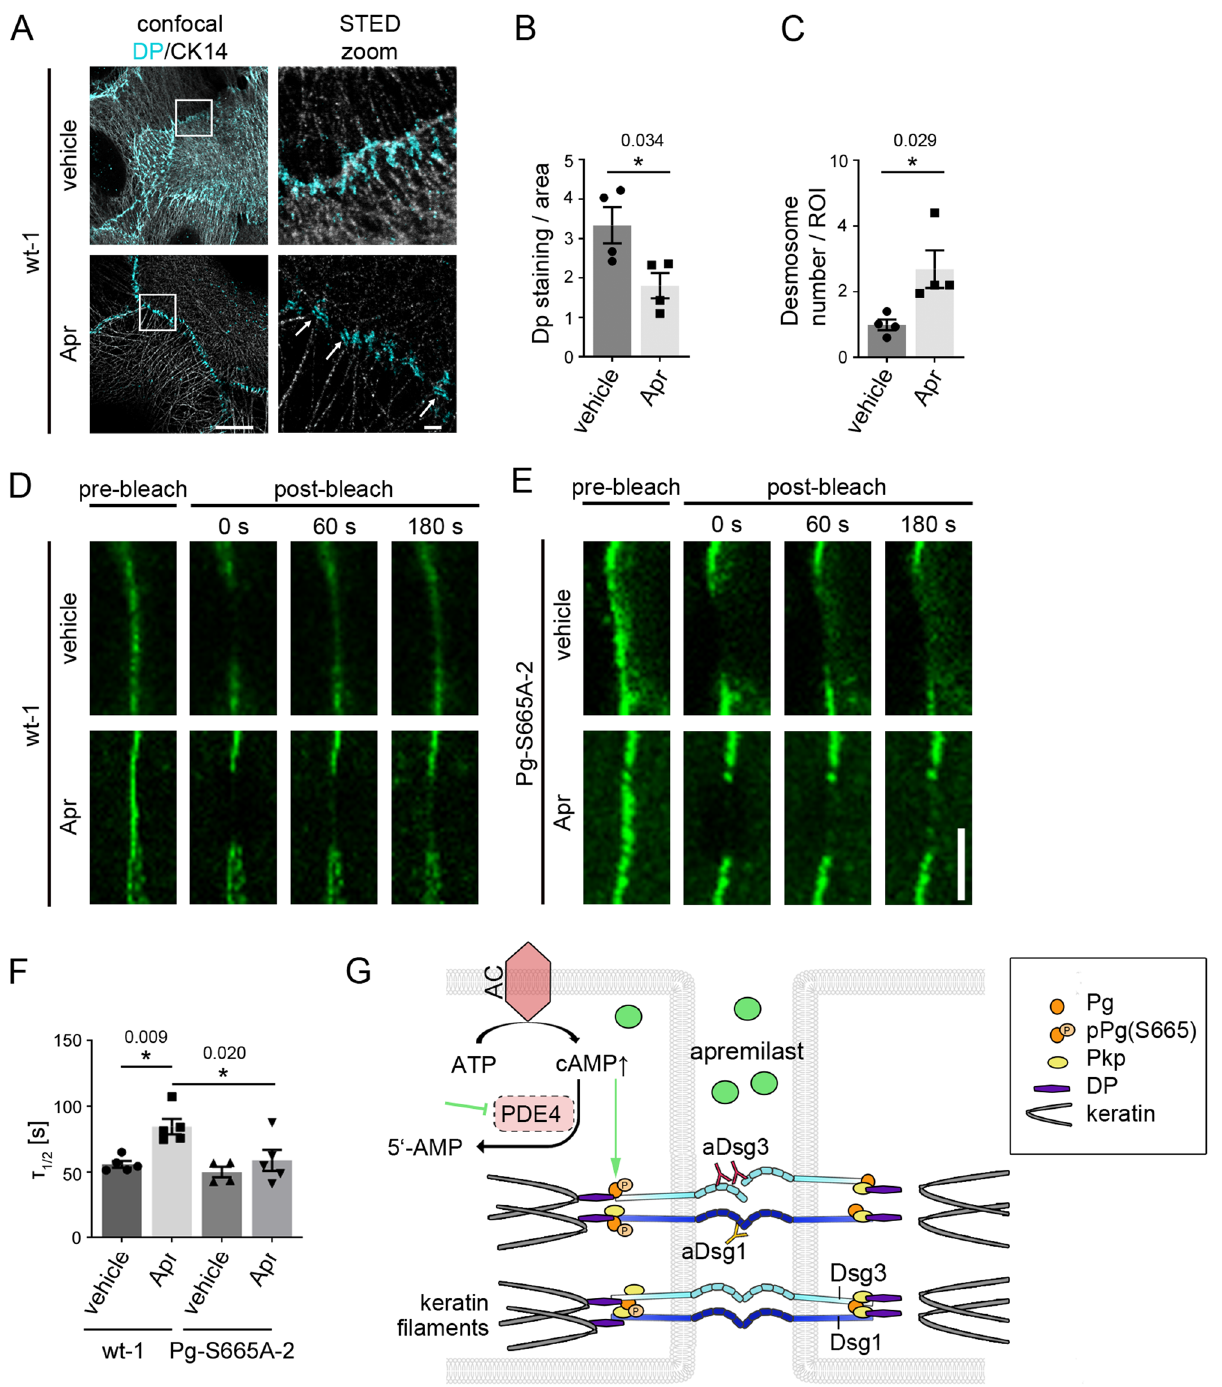
Fig. 7 | Apremilast regulates desmoplakin recruitment and Dsg3 membrane availability. A Representative immunostaining of wt murine keratinocytes incu- bated with apremilast for 2h and stained for desmoplakin (Dp) and cytokeratin 14 (CK14). Under control conditions, Dp was present at linear streaks along the cytokeratin fi lament at cellular contact points. In contrast,after apremilast (10 µ M) treatment,Dpwaspresentindesmosomes(whitearrows).Scalebar=10 µ m.Zoom in areas marked with white rectangles. Scale bar (zoom)=1 µ m. Representative of n =4. B , C Quanti fi cation of Dp staining. Dp-covered area is signi fi cantly reduced after apremilast treatment compared to control cells. In contrast, number of des- mosomes/ROI was elevated. D , E FRAP on murine keratinocytes transfected with Dsg3-GFP. D , F In wt murine keratinocytes, apremilast (10 µ M) lead to enhanced